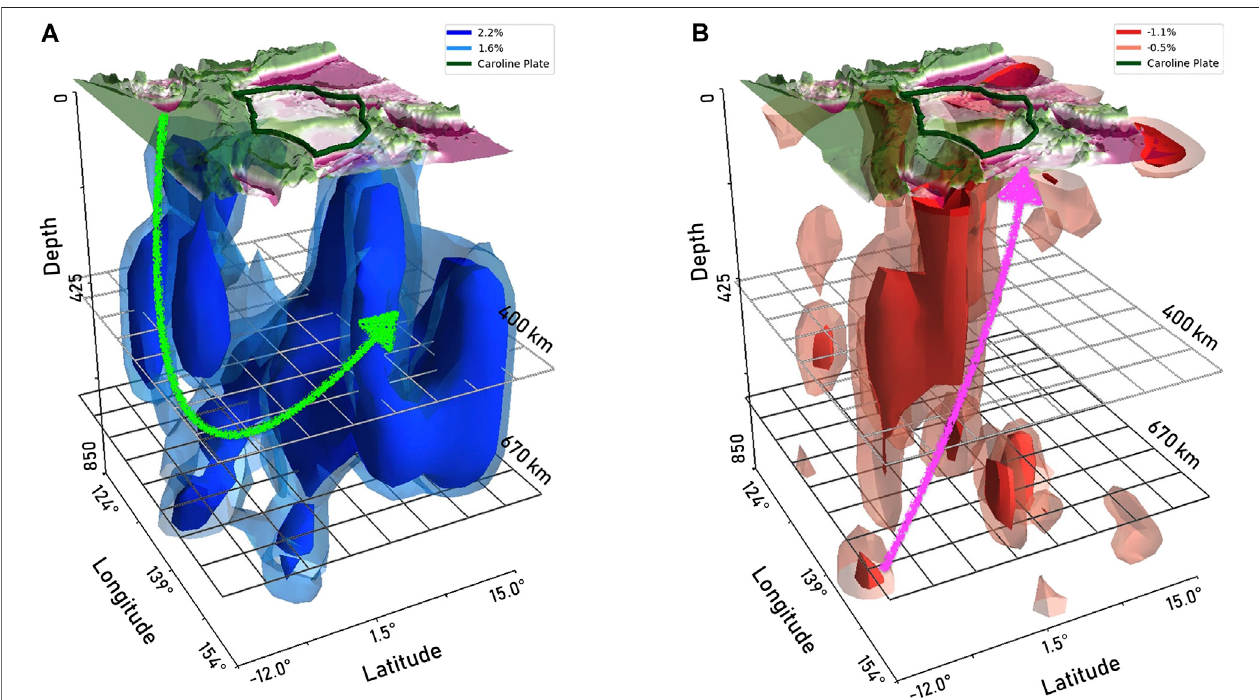
FIGURE2| Three-dimensionalS-wavevelocity(V S )structurebeneaththeCarolineplatedownto850 kmdepthwithinterpretation(arrows).Thegreenperimeterat thesurface(0 kmdepth)indicatestheCarolineplateboundaries. (A) TheregioninbluehasV S 2.2and1.6%fasterthanPREM(DziewonskiandAnderson,1981). (B) The region in red has V S 1.1 and 0.5% slower than PREM. Our model suggests the presence of subducting and stagnant slabs (blue regions) from the neighboring plate boundaries, and the plume (red regions) emerging from the base of the model domain (850 km depth) and extending to the surface. See Supplementary Figure S5 forhorizontalslicesofthemodeland SupplementaryFiguresS6 – S8 forverticalslicesofthemodel.Agreenarrowinapanel (A) indicatestheslabimagedwithhigh seismic velocities, and a magenta arrow in (B) indicates slow-velocity material.